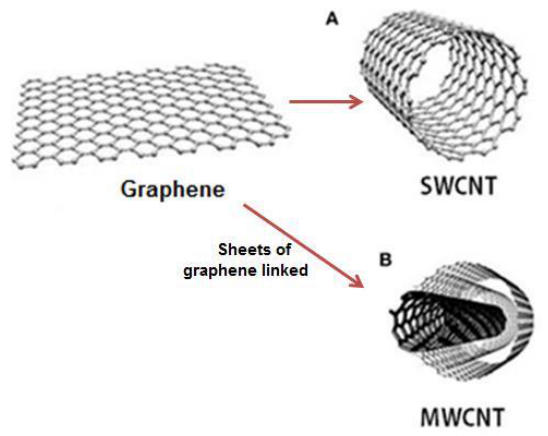
Figure 4. Graphene and carbon nanotubes as structures: ( A ) single-wall carbon nanotubes (SWCNT) and ( B ) multi-walled carbon nanotubes and ( B ) multi-walled carbon nanotubes (MWCNT).